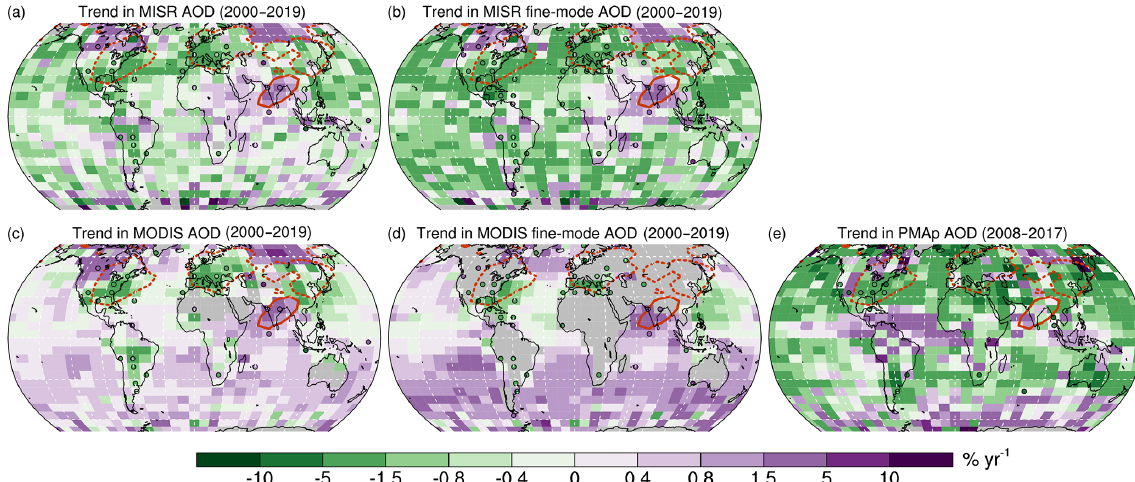
Figure 2. Linear trends (2000–2019) of (a) aerosol optical depth (AOD) as retrieved from the Multi-angle Imaging Spectroradiometer (MISR; Garay et al., 2017) on board the Terra satellite, where the coloured circles show the AOD trends from the AERONET ground-based sun-photometer network (Holben et al., 1998; Giles et al., 2019) where data since 2000 are available. Panel (b) is the same as (a) , but for the fine-mode AOD, i.e. the AOD due to aerosols with radii smaller than 1µm. Panels (c) and (d) are the same as for (a) and (b) , but with retrievals from the MODerate Resolution Imaging Spectroradiometer (MODIS; Levy et al., 2013) (fine-mode AOD unavailable over land) from the Terra satellite, averaged (starting in 2002) with MODIS retrievals from the Aqua satellite; (e) Polar multi-sensor aerosol product (PMAp) AOD as retrieved from the Global Ozone Monitoring Experiment-2 (GOME-2) instrument on board EUMETSAT’s Metop-A satellite that is available only for 2008 to 2017. Isolines as in Fig. 1. A figure that shows the trends in absolute units is provided as